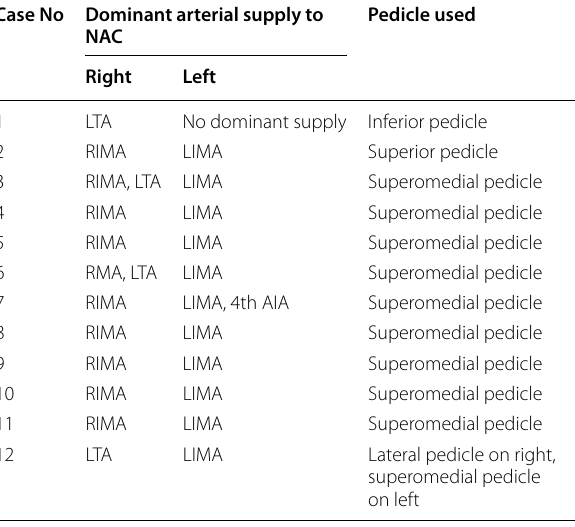
LIMA Left internal mammary artery, RIMA Right internal mammary artery, LTA Lateral thoracic artery & AIA Anterior intercostal artery